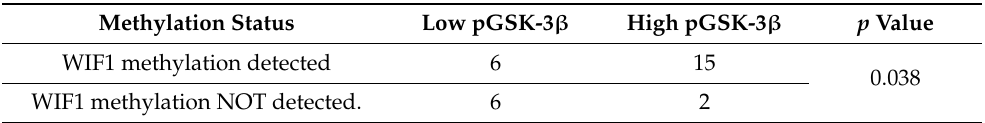
Figure 2. High methylation status of the WIF1 promoter region in MCL cell lines and patients. ( A ) Methylation-specific PCR of the WIF1 promoter region was performed on 5 MCL cell lines. With the exception of REC1, signals from the methylation-specific PCR were readily detectable. ( B ) Methylation-specific PCR of WIF1 promoter region performed on 4 MCL patient samples. M indi- cates primer specific for methylated site, U indicates primer specific for unmethylated site. Neg indicates no DNA negative control. Table 1. A significant correlation between the high expression of pGSK-3 β and WIF1 methylation in 29 cases of mantle cell lymphoma.